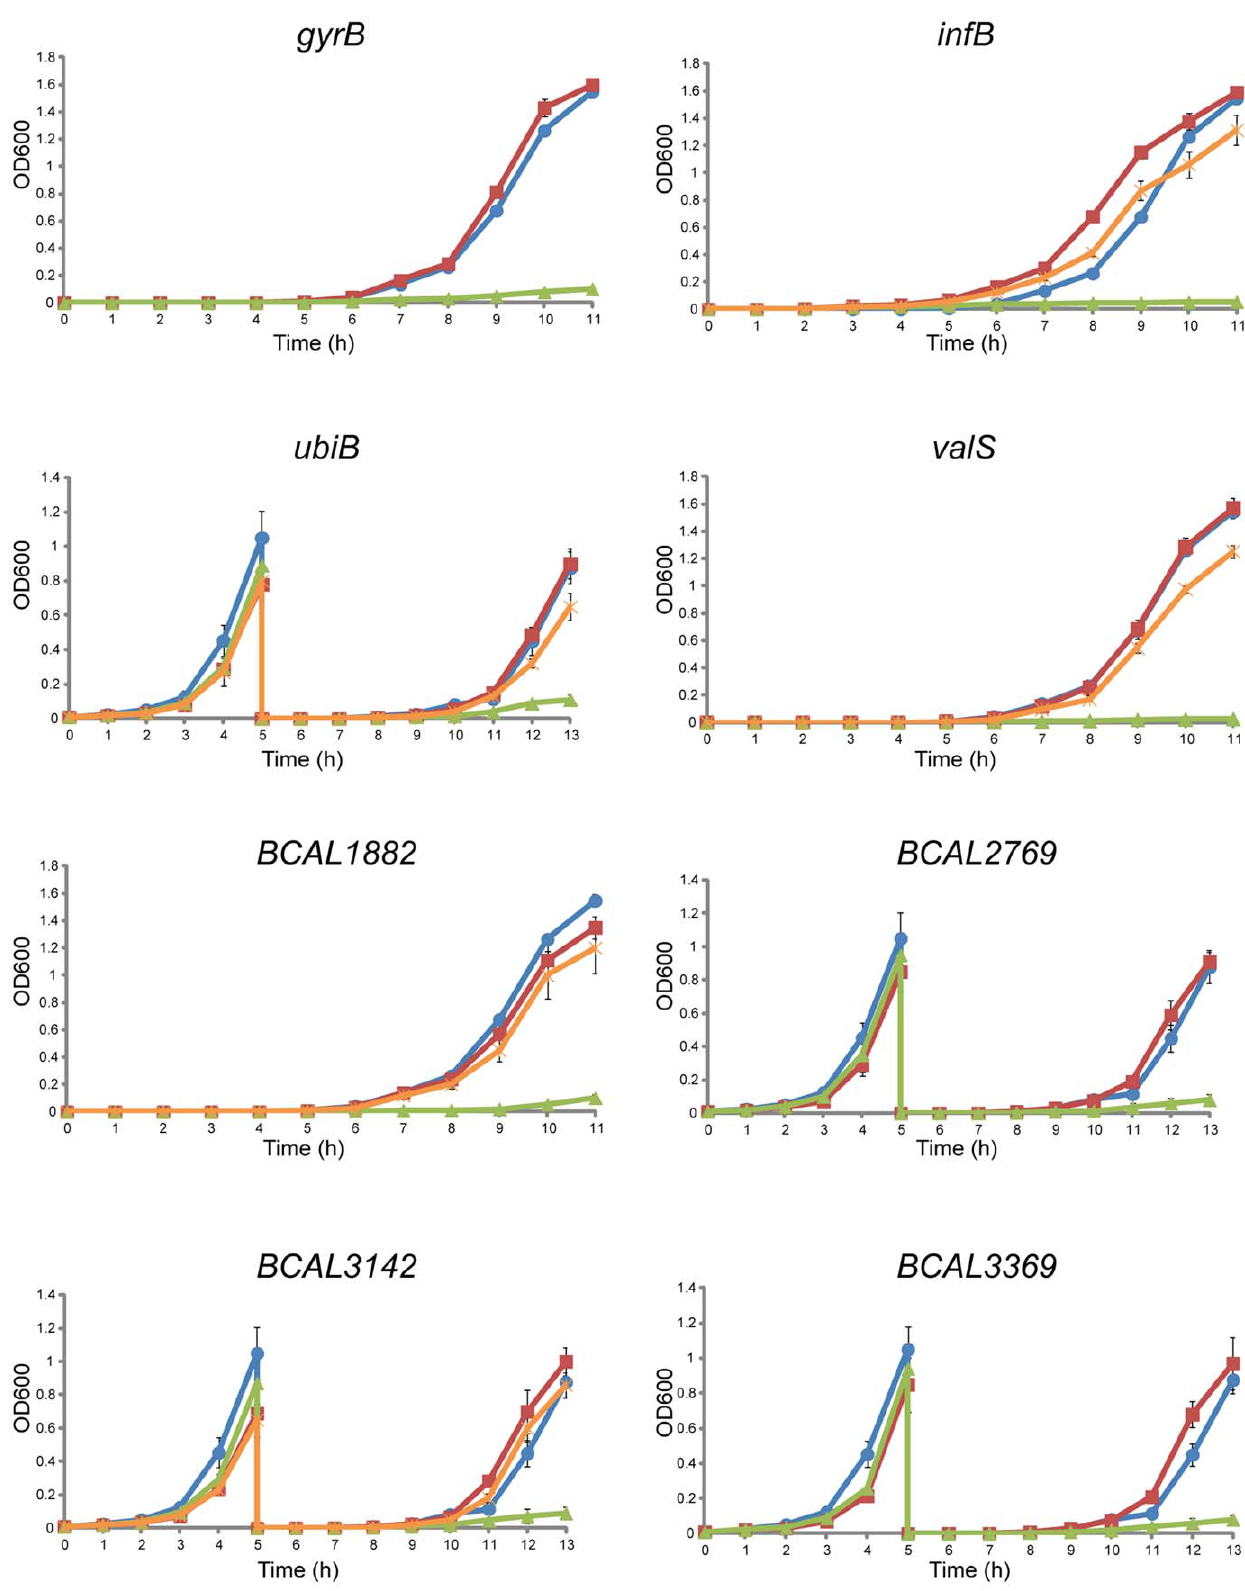
Figure 3. Investigated genes are essential for growth and viability of B.cenocepacia . Growth curves of the wild type H111 (circles), and rhamnose-inducible mutants: H111 infB , H111 gyrB , H111 uniB , H111 valS , H111 BCAL1882 , H111 BCAL2769 , H111 BCAL3142 and H111 BCAL3369 in the presence of rhamnose (squares) or glucose (triangles). Complementation of mutants H111 infB c, H111 ubiB c, H111 valS c, H111 1882 c and H111 3142 c in